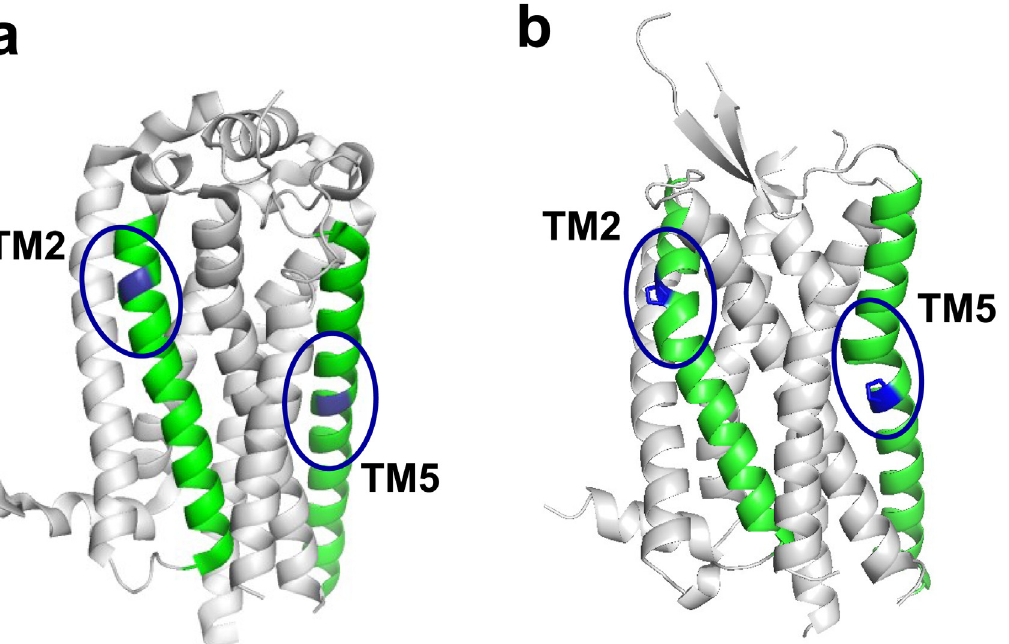
Fig 1. Structure of selected GPCRs. Ribbon representation of the crystal structure of (a) S1P1R (PDB # 3V2Y) and (b) OX2 (PDB # 4S0V). TM2 and TM5 are green. Positions 2.59 and 5.50 are blue. The proline residues at positions 2.59 and 5.50 in OX2 are shown as sticks. Ovals indicate the positions of the helical distortions, if